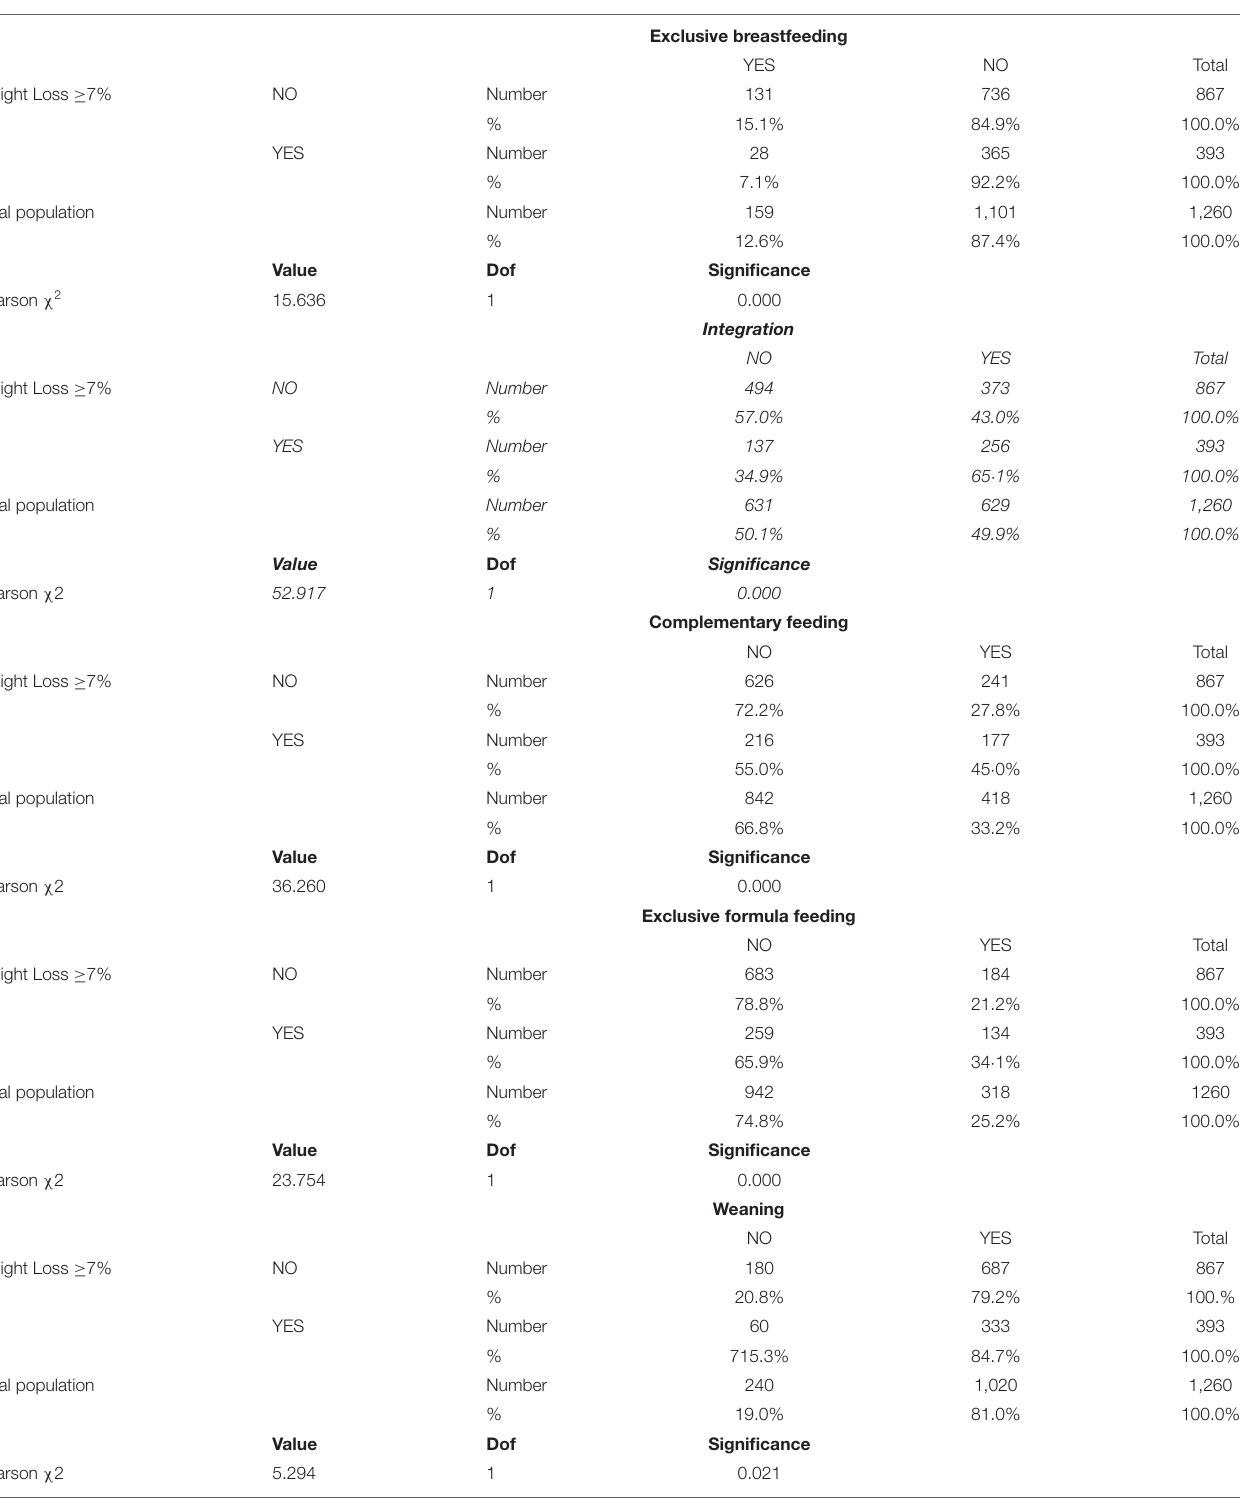
TABLE 2 | Pearson chi-square